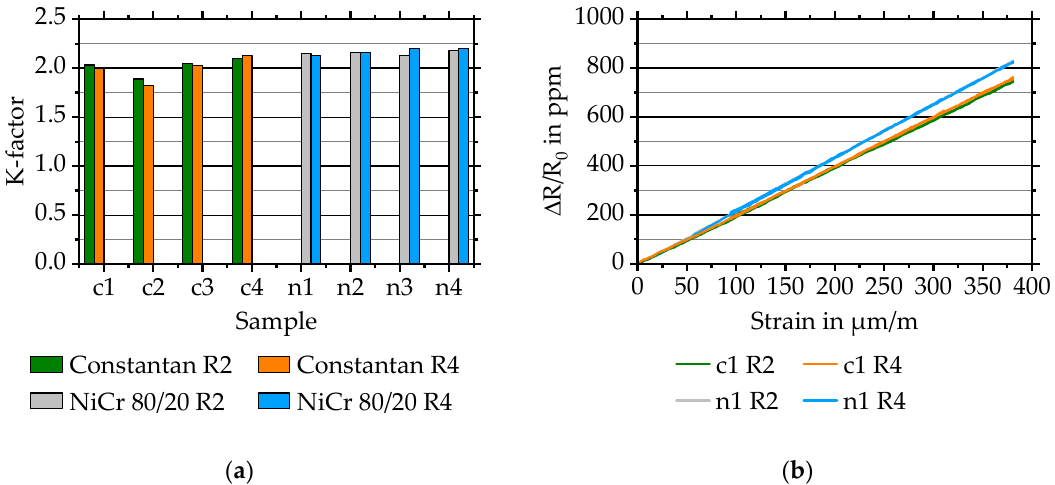
Figure 5. ( a ) Evaluated k-factors for directly deposited Constantan (c1–c4) and NiCr 80 / 20 (n1–n4) quarter-bridge strain gauges R2 and R4. ( b ) Relative resistance change ∆ R / R 0 over strain ε for two simultaneously deposited quarter-bridges, R2 and R4, made of Constantan (c1) and NiCr 80 / 20 (n1).